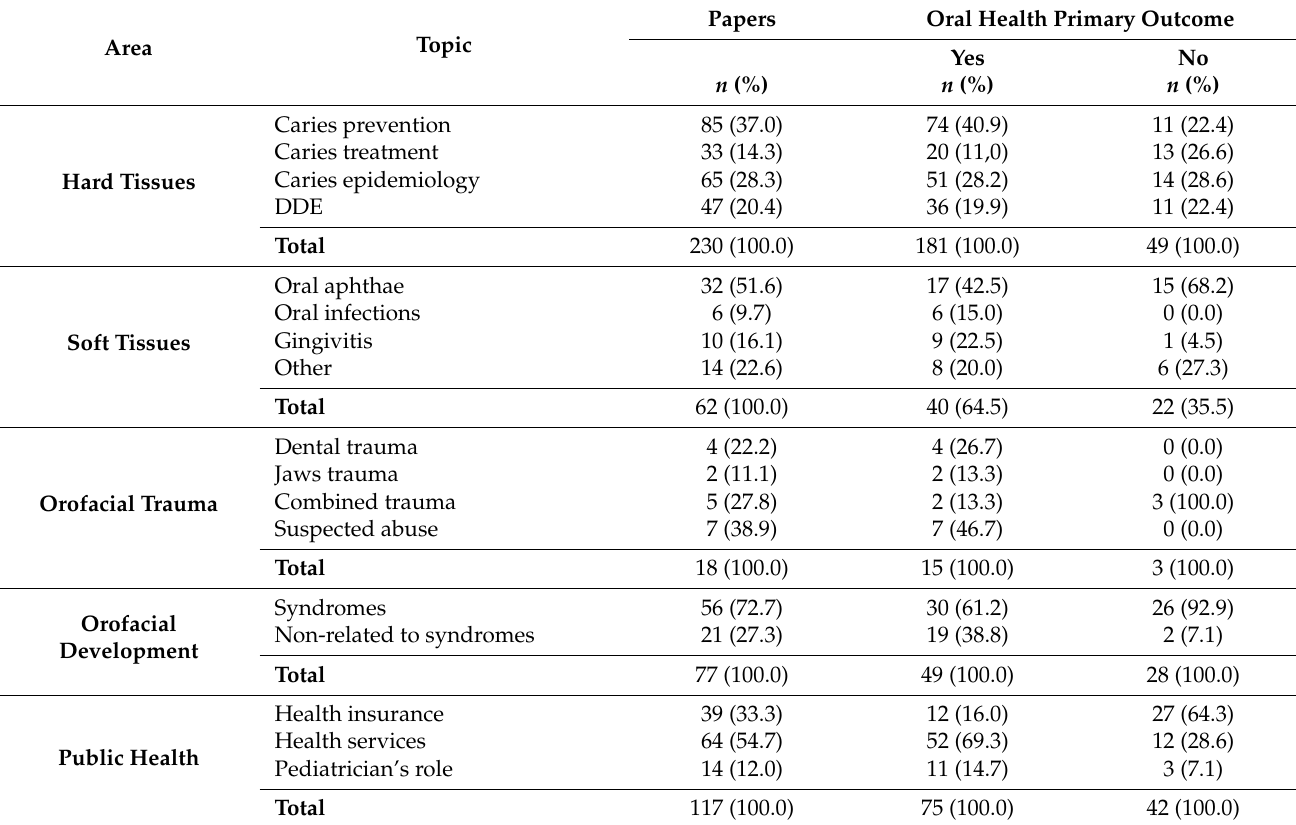
Table 2. Included papers by area, topic, and the primary or not primary